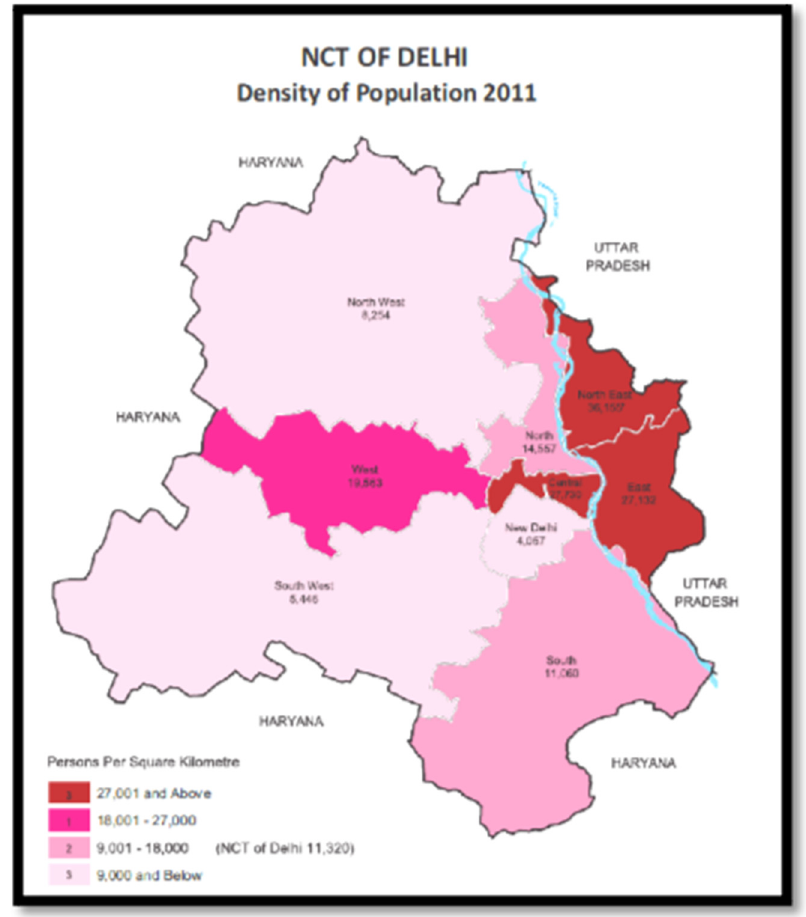
Figure 1. Population Density—National Capital Territory (NCT) of Delhi.